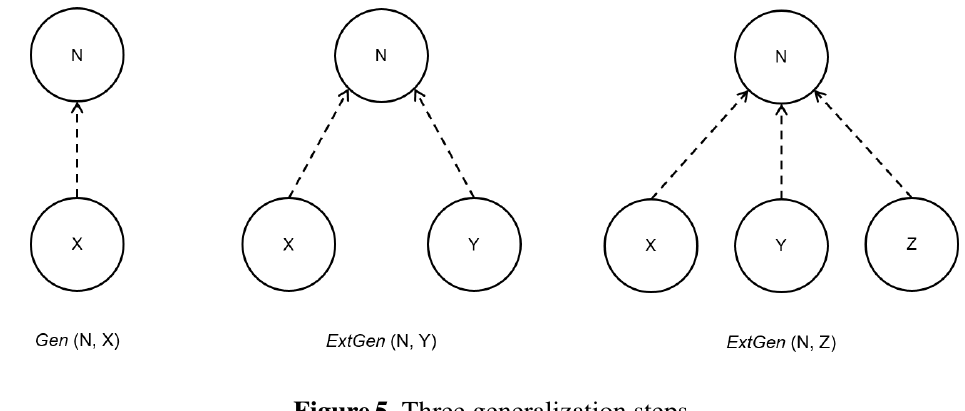
Figure 5. Three generalization